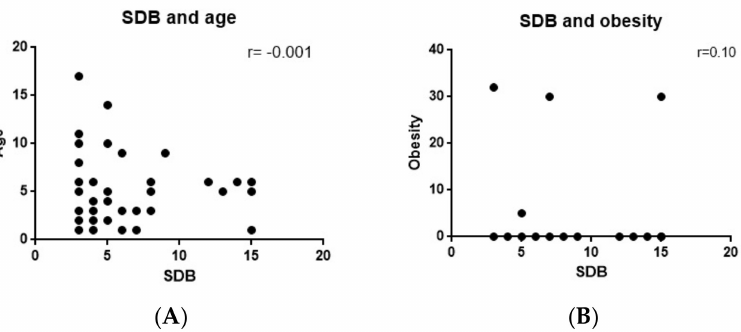
Figure 4. Spearman correlation. ( A ) SDB × age, ( B ) SDB × obesity. SDB—sleep-disordered